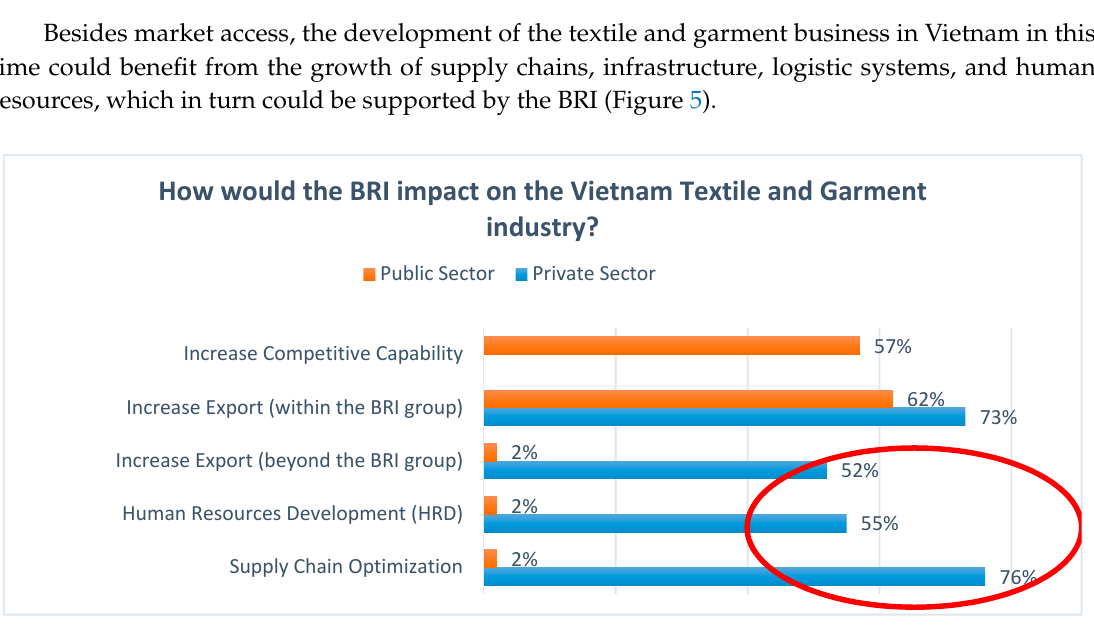
Figure 5. Export opportunities for the Vietnam Textile and Garment industry (Source: Authors’ analysis).